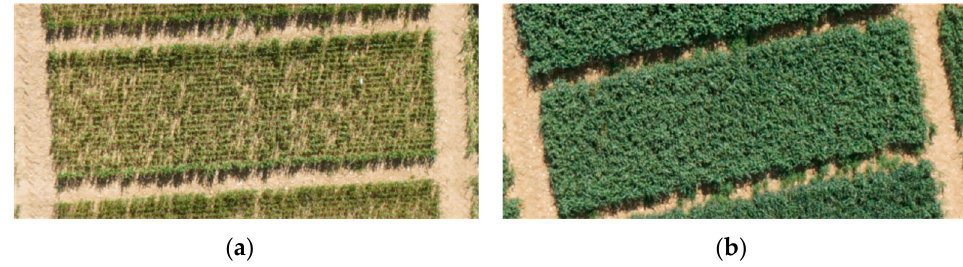
Figure 7. Imagery collected by the UAV flying at 45 m height of an unfertilised (N1) treatment plot ( a ) compared to an N4 (350 kg·ha − 1 fertiliser application) treatment plot ( b ). Mercia wheat cultivar shown in both cases.